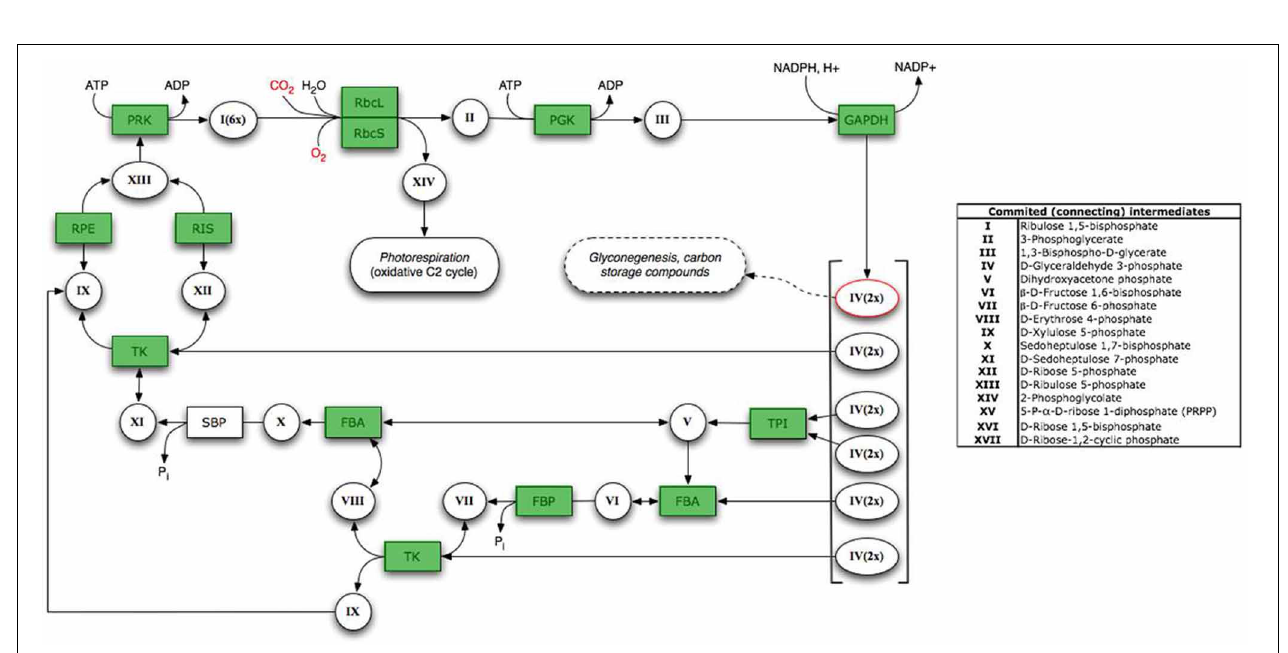
(2.3mmol Fe(II) L − 1 in live vs. 10.5mmol Fe(II) L −− 1 in control; (C) second transfer of reduced NAu-2-oxidizing enrichment from oxidized Ringold material (6.0mmol Fe(II) L − 1 in live vs. 12.7mmol Fe(II) L − 1 in control).